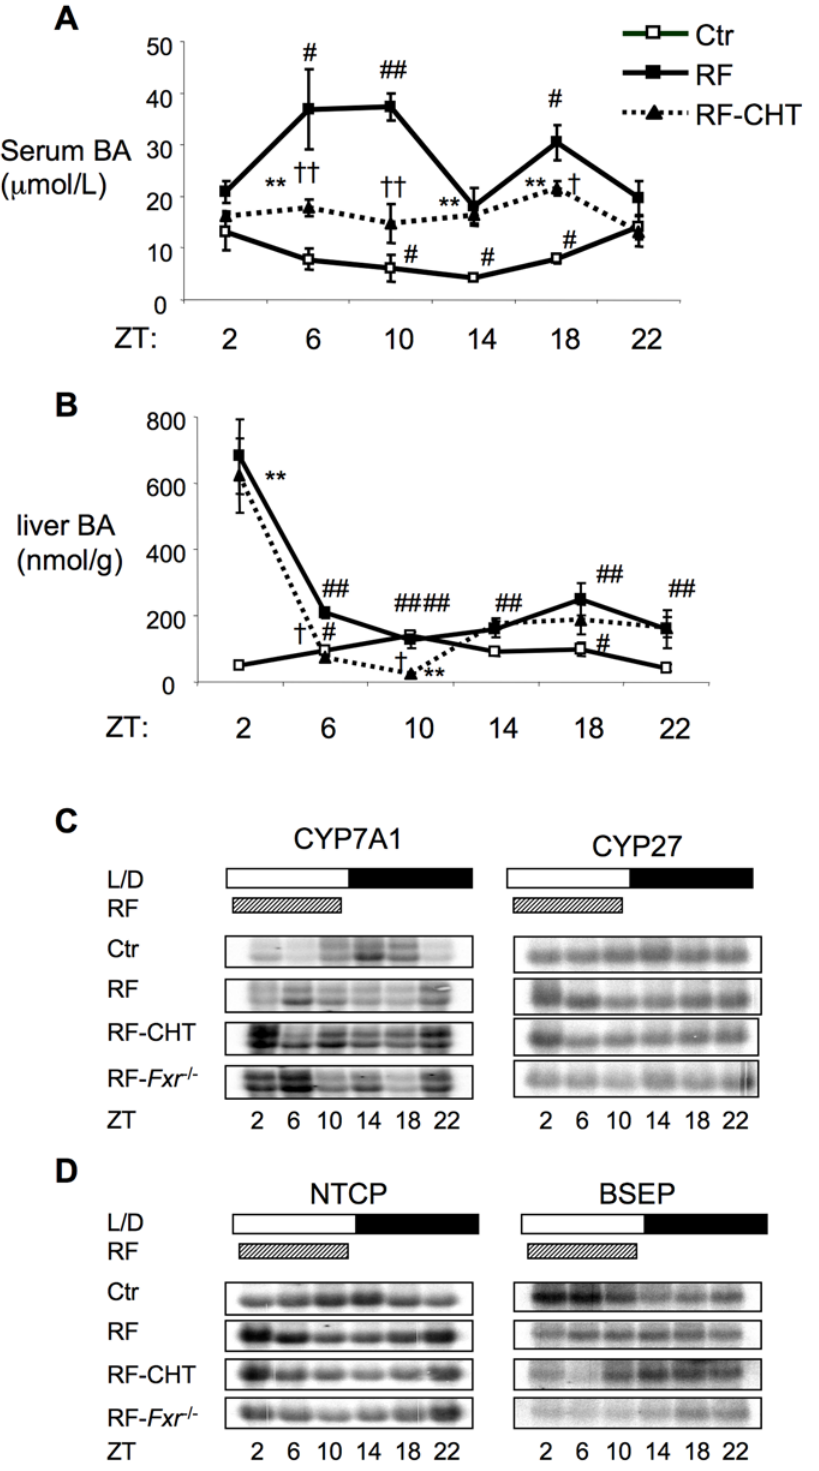
Figure 1. Circadian variation of serum and hepatic bile acid levels and expression of enzymes in mice is reversed by restricted feeding (RF). A. and B. Circadian variations of serum and hepatic bile acid levels in four groups of mice: wild-type mice without restricted feeding (Ctr), wild-type mice under restricted feeding (RF) and wild-type mice on 2% cholestyramine diet under restricted feeding (RF-CHT). Mice were under normal light-dark cycle with lights on at 7:00 AM (ZT0) and restricted fed from ZT2-ZT10 for 5 days prior to bile acid analysis for the RF groups. Values are expressed as mean 6 SEM. n=6–8 each group for 1A and n=3–5 for each time points in 1B. * P , 0.05 and **P , 0.01 compared to Ctr group. { P , 0.05 and {{ P , 0.01 compared to RF group. # P , 0.05 and ## P , 0.01 compared to RF ZT2 in the same group. C. Circadian expression levels of enzymes involved in bile acid synthesis and D. transporters involved in the uptake and secretion of bile acids in the liver by Northern analysis (n=3–4 each time point). Loading control 28S is included in Figure SS1C.